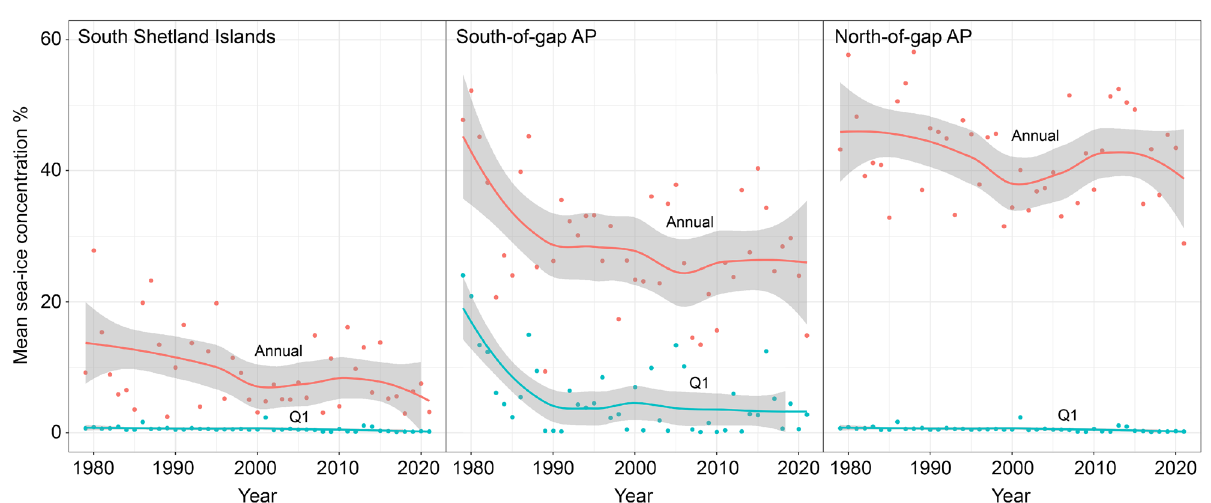
Figure 4. Mean annual and Q1 (January–March) sea-ice concentration trends 1979–2021. Red and green curves represent the smoothed regression model fit for annual and first quarter trends respectively, while the gray ribbons represent the 95% credible